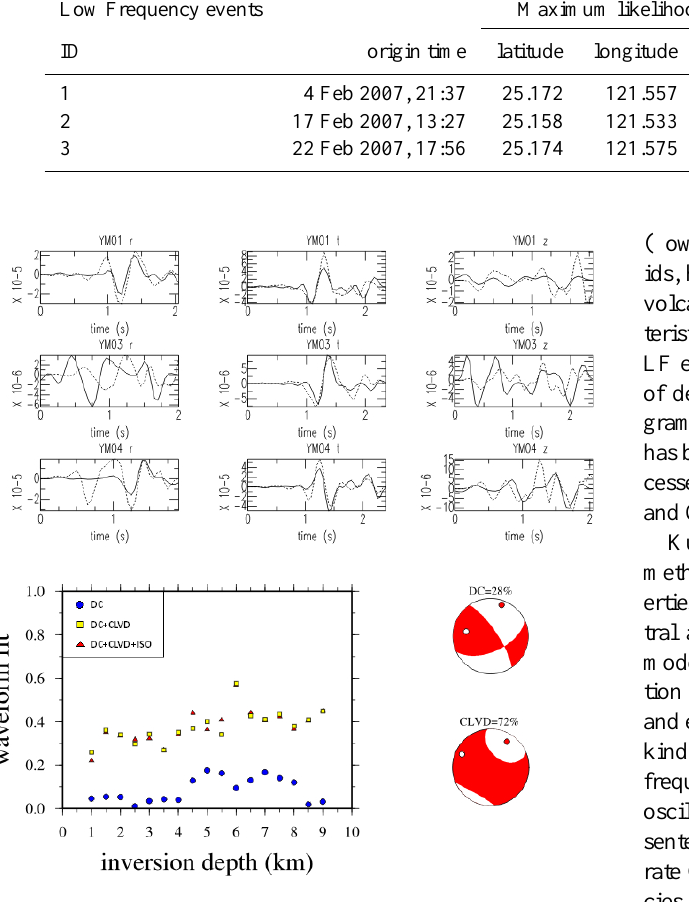
Fig. 8. Moment tensor inversion results for the 24 April 2006 earth- quake. Top panel: Comparison of observed (solid lines) and pre- dicted waveforms (dashed lines) for the deviatoric moment tensor inversion at 6km depth. Lower panel: Diagram showing the wave- form fit for the three different sources assumed (DC, DC+CLVD, DC+CLVD+ISO) for each of the inversion depths. Also shown are the two beach balls representing the DC and deviatoric moment tensor of the solution with the highest